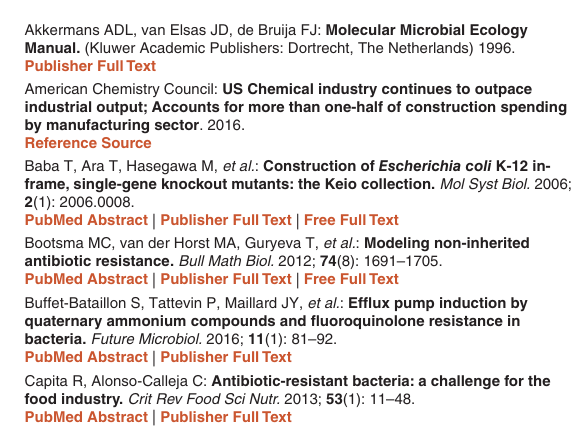
evidence of an adaptive response . Antibiotic resistance response in the presence and absence of copper.